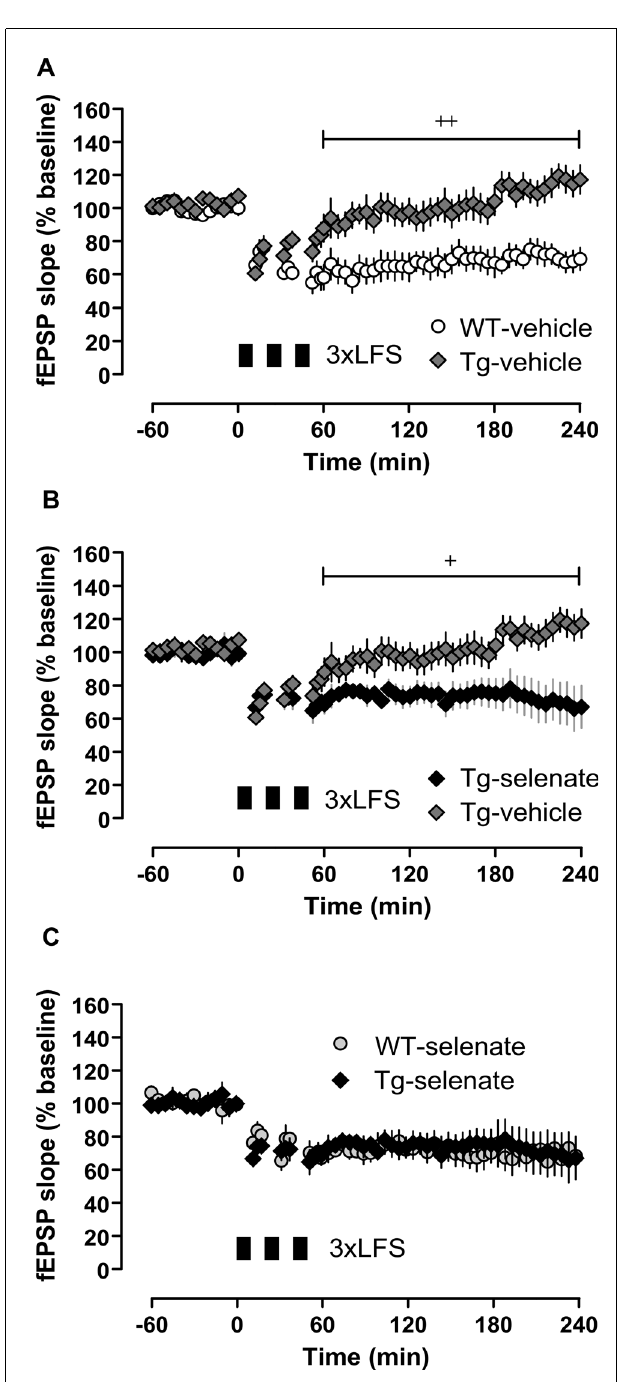
FIGURE 5 | Chronic selenate treatment restored synaptic plasticity [long-term depression (LTD)] in Tg mice. RM-ANOVA of all four groups confirmed a significant main effect of group F ( 2,28 ) = 6.843, p = 0.001. (A) Vehicle-treated Tg mice ( n = 10) failed to express robust LTD which was intact in vehicle-treated WT siblings ( n = 8). (B) Selenate rescued LTD in Tg ( n = 6) compared with vehicle-treated siblings ( n = 10). (C) The rescued LTD in selenate-treated Tg mice matched exactly the time-course of LTD in selenate-treated WT animals ( n = 8). Mean ± SEM is given. Bar with cross(es) indicates a significant difference in Tukey’s post hoc multiple comparisons, + p ≤ 0.05, ++ p ≤